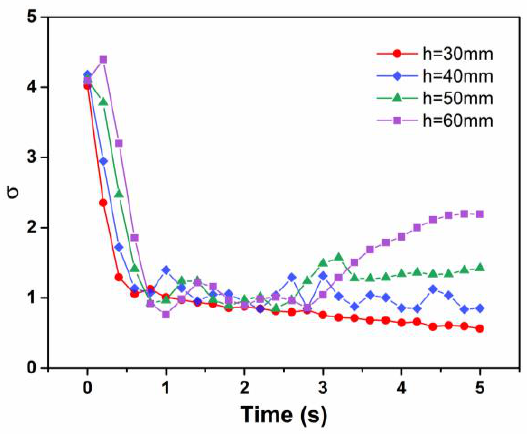
Figure 11. Time evolution of σ for different blade heights, N = 600 rpm.